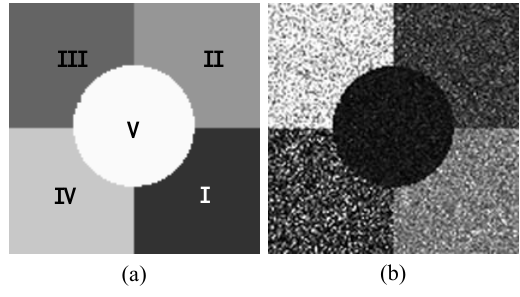
(c)Figure 1. Simulated images, (a) template for simulation, (b) simulated image.